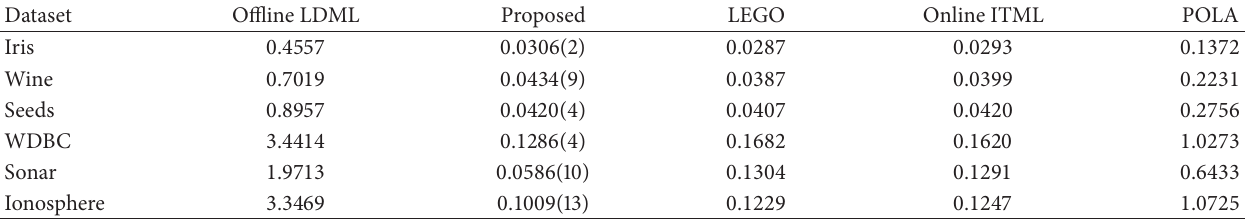
Table 3: Running time (s) comparison with the state-of-the-art metric learning methods on the normal size data sets.